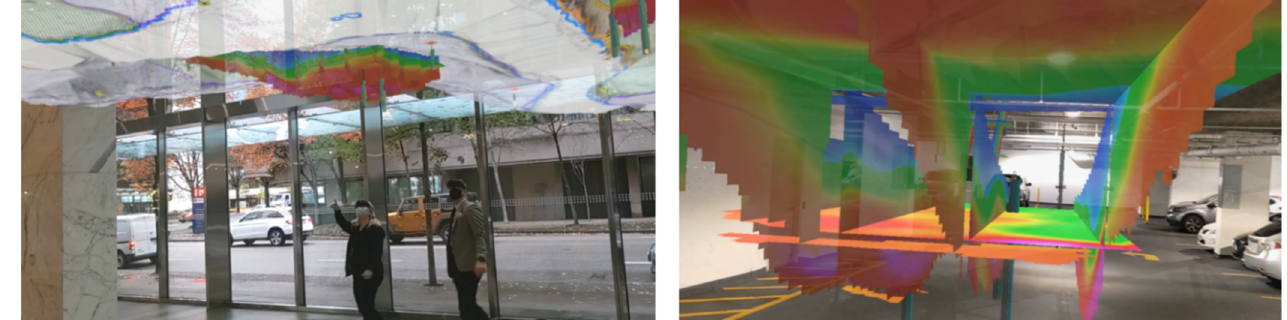
Figure 13. Sometimes the right presentation of the model requires a large space, such as the hall of a building ( left ) or a parking lot passageway ( right ). Data shown include boreholes and geophysical horizontal and vertical Electrical Resistivity Value profiles (pictures courtesy of BGC/Clirio).